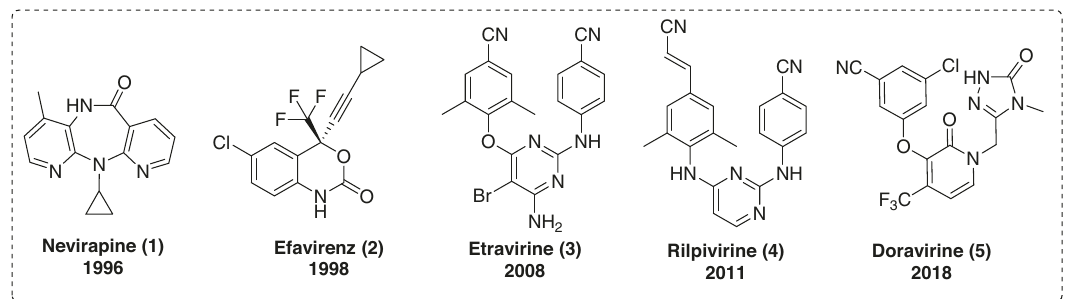
Fig. 1 Chemical structures of NNRTI drugs approved by U.S. FDA. Nevirapine (NVP, 1 ), efavirenz (EFV, 2 ), etravirine (ETR, 3 ), rilpivirine (RPV, 4 ) and doravirine (DOR, 5